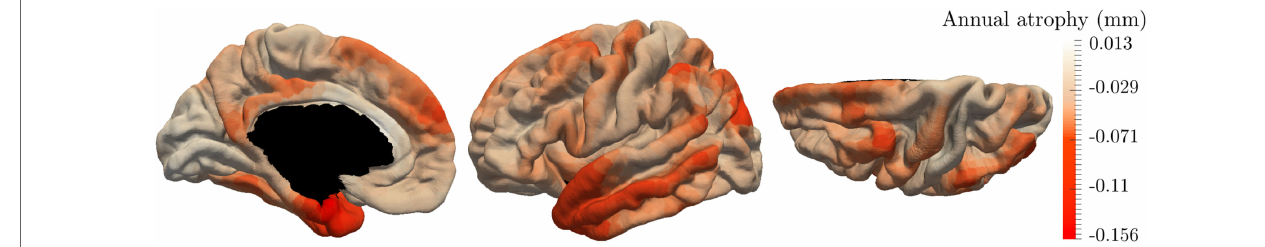
FIGURE 5 | Annual rate of atrophy mapped over the brain surface used as initialization of our algorithm. Given one area, the corresponding rate of atrophy is obtained as the average regression coefficient of the linear regressions applied to each patient independently.